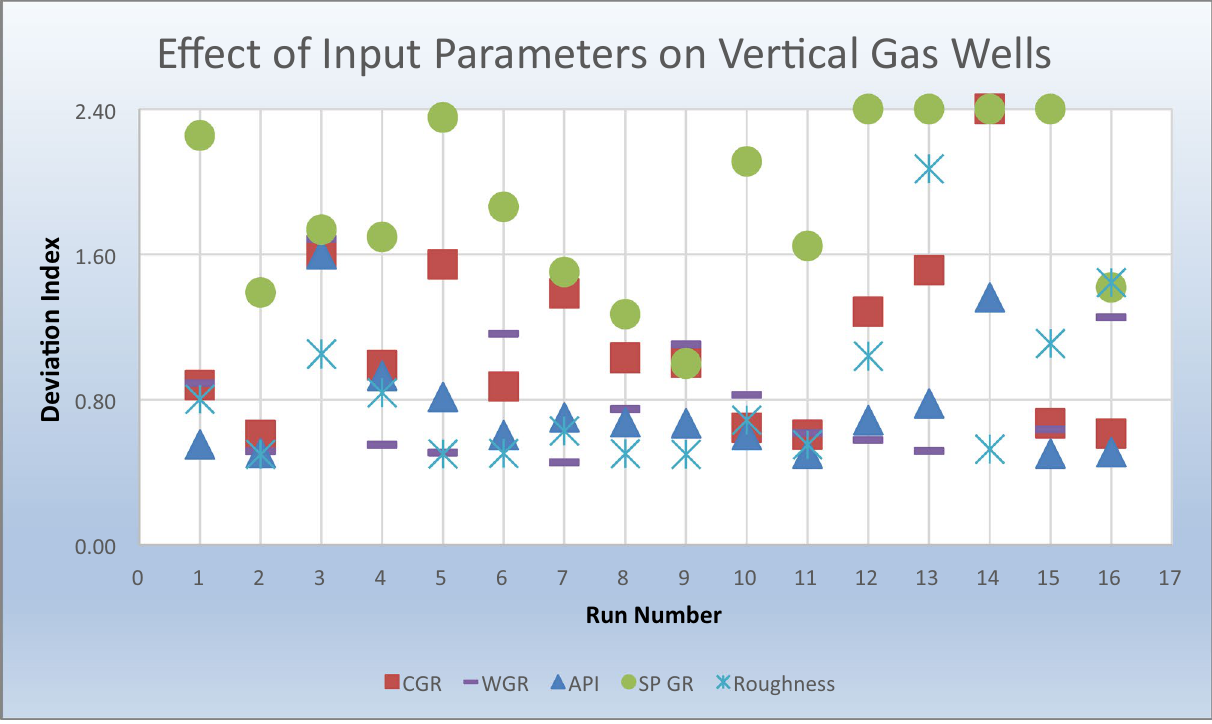
Fig. 14 Effect of different input parameters on vertical wells using deviation index method